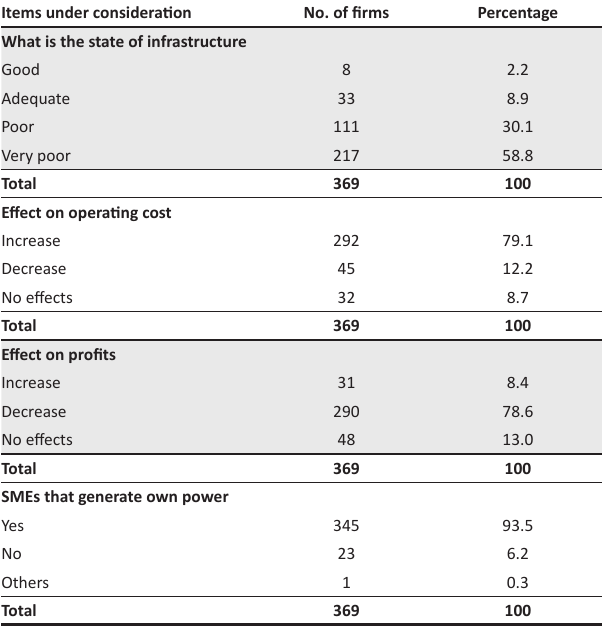
TABLE 1: State and effect of infrastructure on operating cost and profit of sampled SMEs. Items under consideration No. of